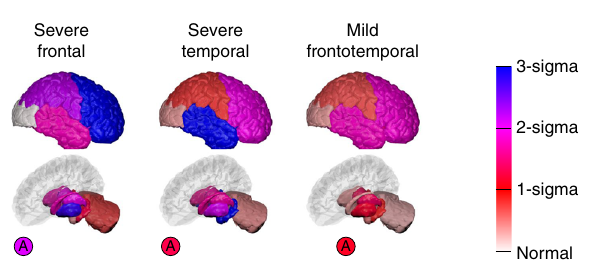
Fig. 6 Subtypes-only model for GENFI; not accounting for disease stage heterogeneity. Brain diagrams as in Fig. 2, but here each diagram represents a different subtype, which we refer to as severe frontal, severe temporal and mild frontotemporal. There is no notion of disease stage in the subtypes-only